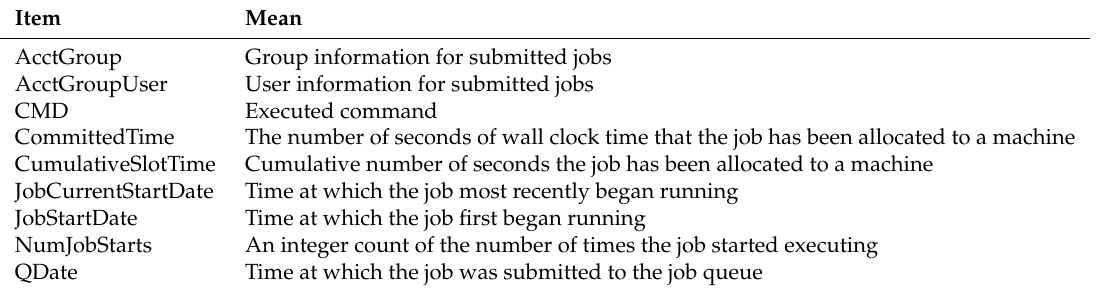
Table 1. Meaning of items extracted with condor_history [23].